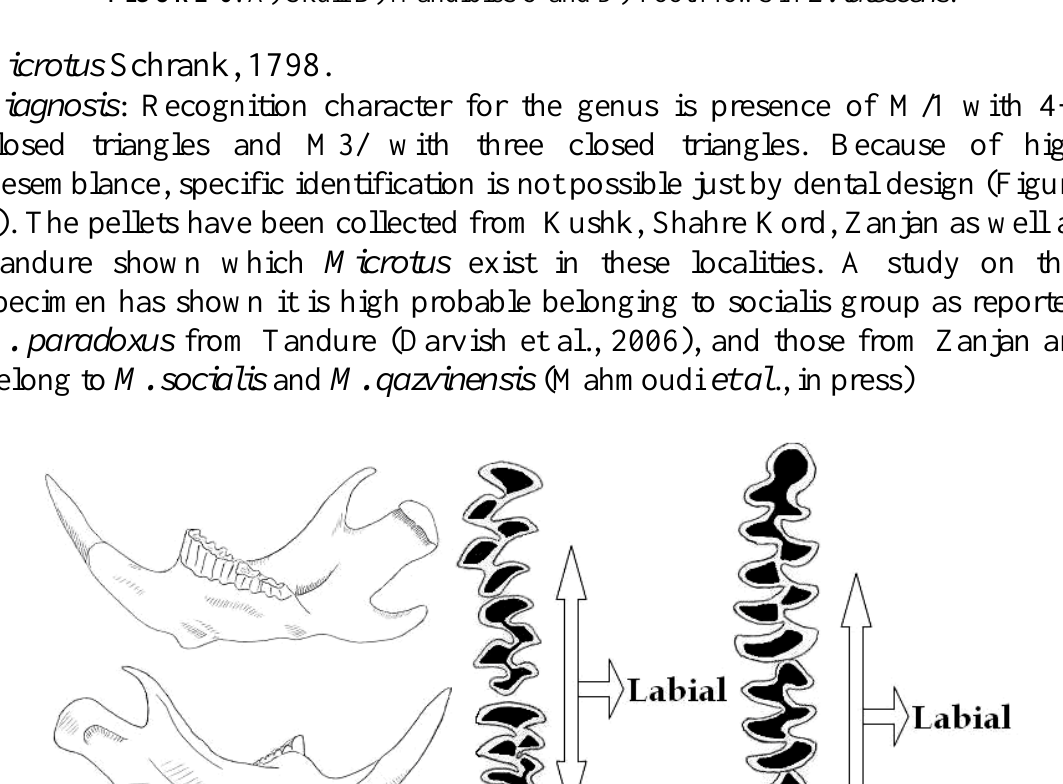
FIGURE 6 : A) Skull B) Mandibles C and D) Tooth rows in E. lutescens .